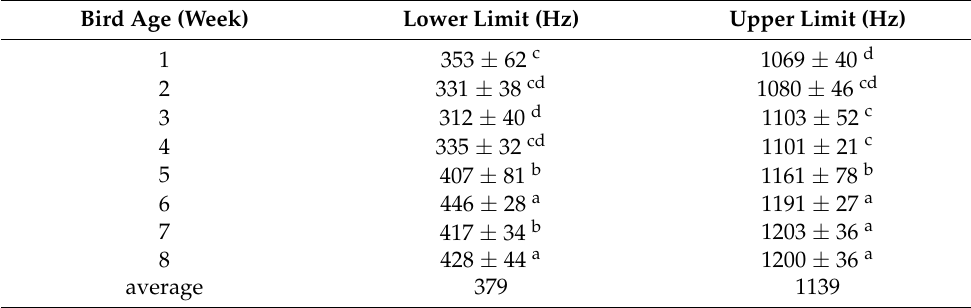
Table 3. Frequency range of fan at different bird ages (mean ±